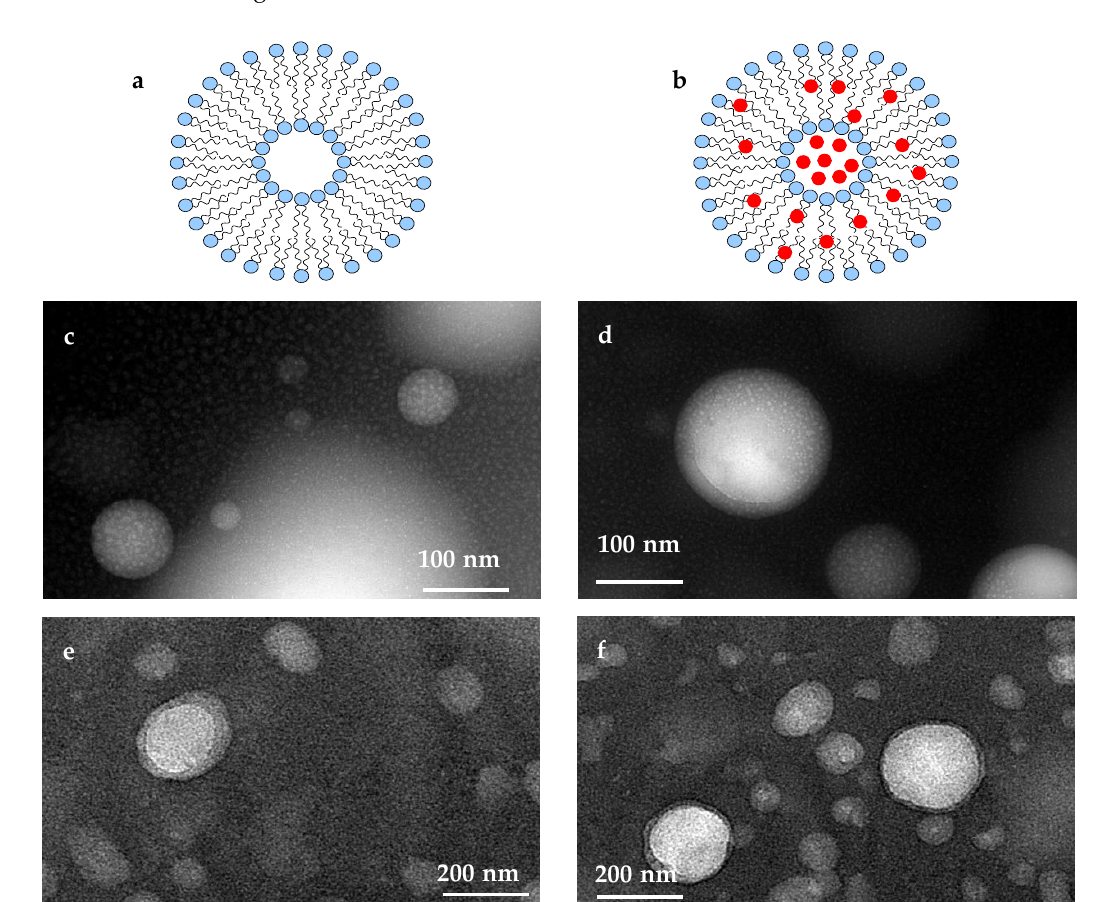
Figure 2. Schematic illustration of nanoliposomes: ( a )—unloaded nanoliposomes, ( b )—AC-loaded nanoliposomes; TEM images of nanoliposomes: ( c )—unloaded nanoliposomes, ( d )—AC-loaded nanoliposomes; TEM images of nanoliposomes representing the bilayer nature of them: ( e )—unloaded nanoliposomes, ( f )—AC-loaded nanoliposomes.